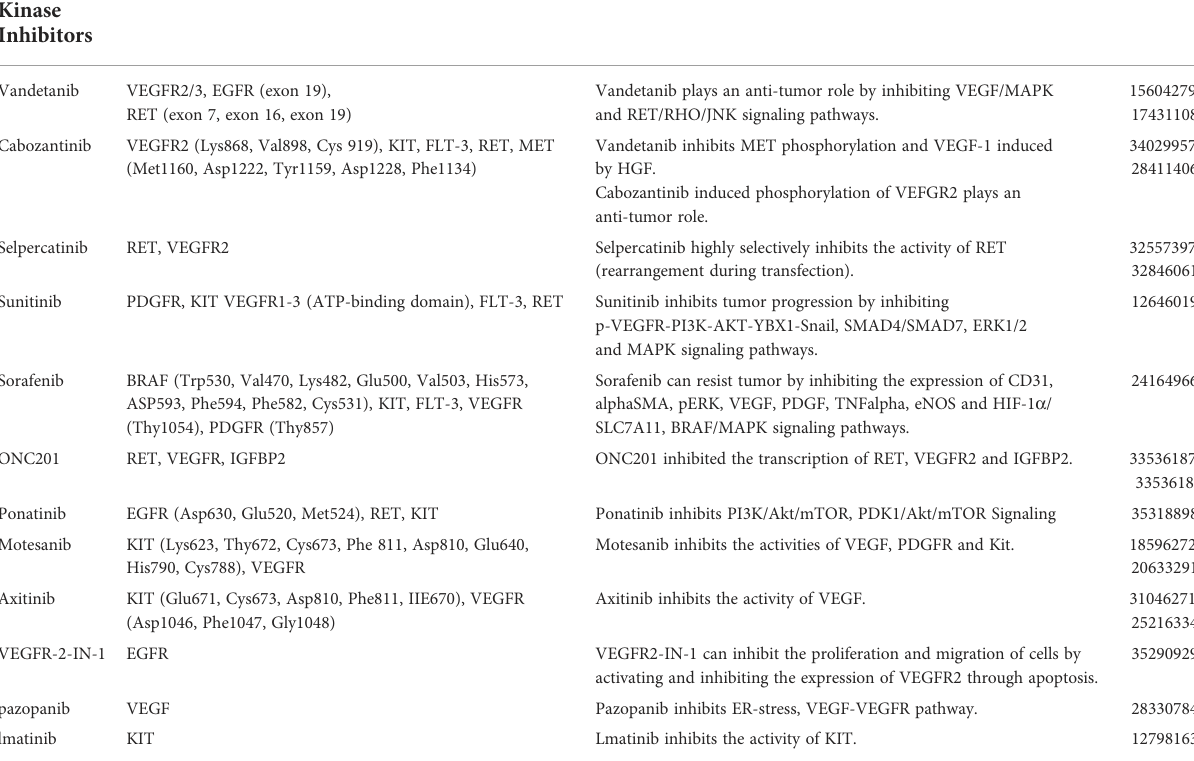
TABLE 1 Drug target and